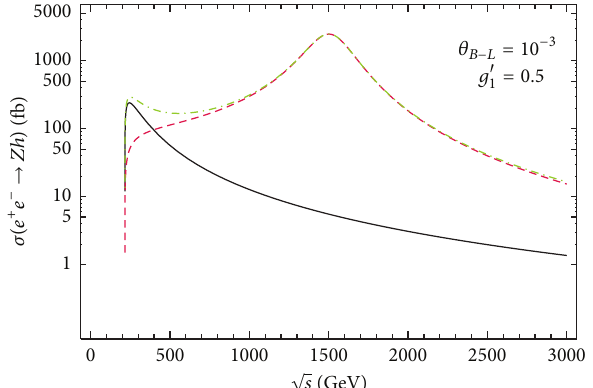
Figure 3: 𝑍 󸀠 width as a function of 𝑔 󸀠 1 for fixed values of 𝑀 𝑍 󸀠 . Starting from the bottom, the curves are for 1500 , 2000 , 2500 GeV, respectively.